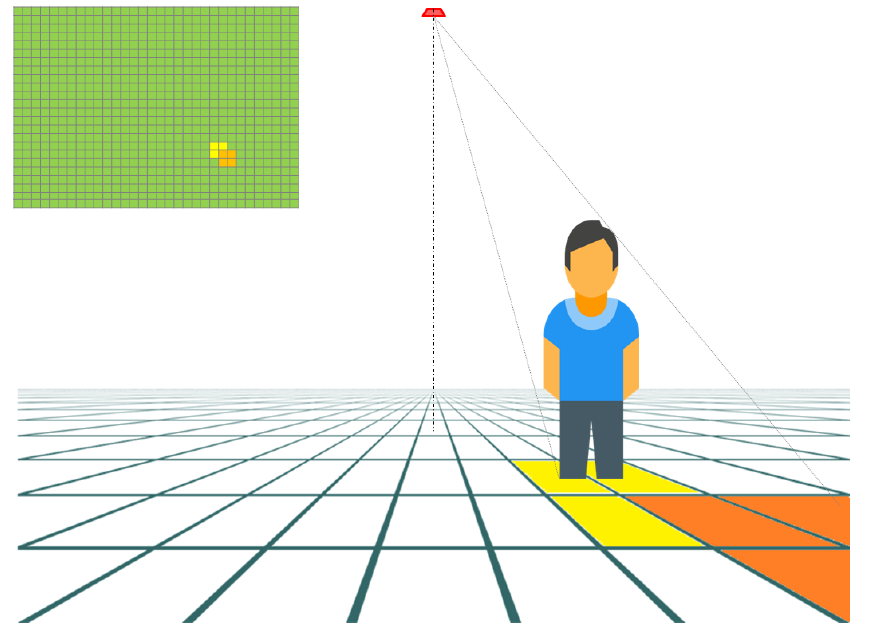
Figure 4. A simplified example of a sensor placed on the ceiling, the coverage of its pixels and the generated frame (upper left